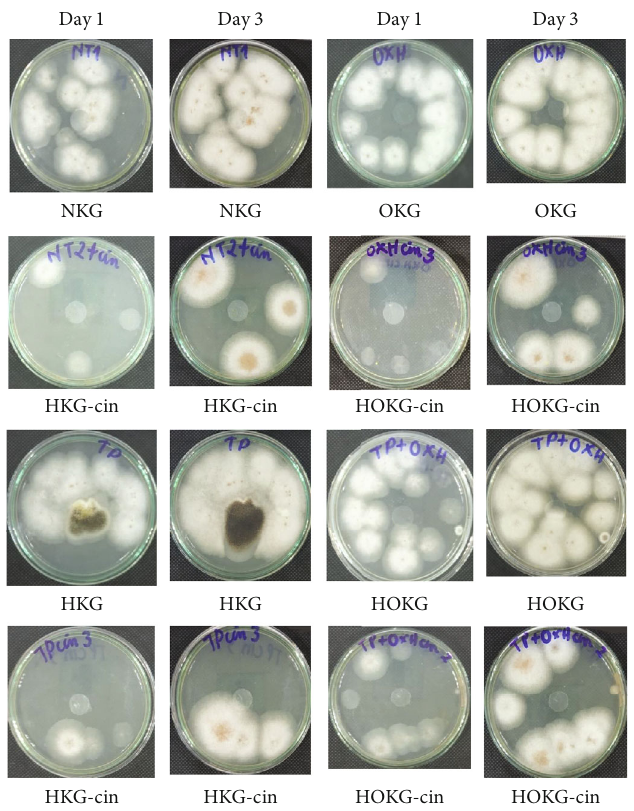
Figure 8: Antifungal activity of KG-starch fi lms with and without cinnamaldehyde for 3 days against C. gloeosporioides.